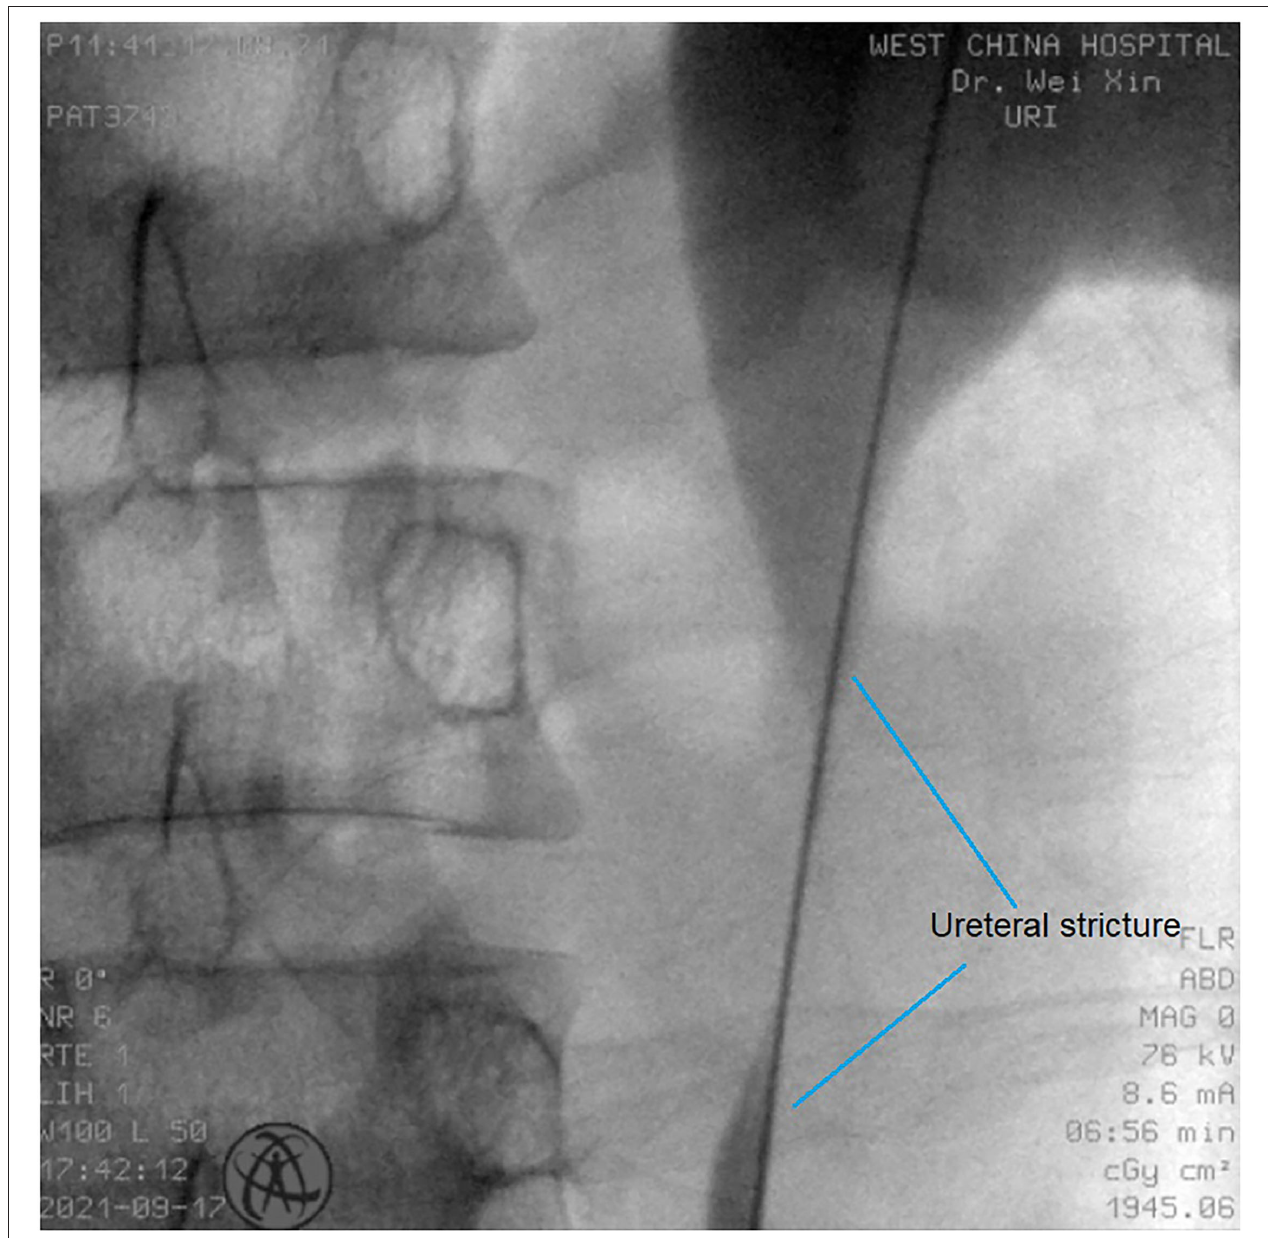
FIGURE 1 | The position and length of ureteral stricture are determined by retrograde or antegrade